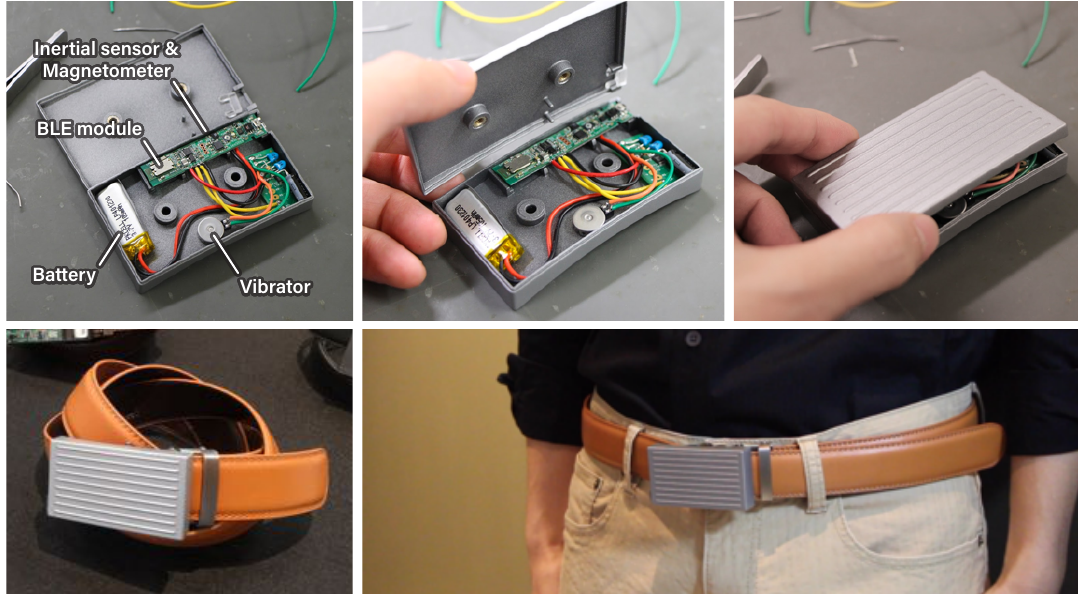
Figure 3. Device and circuit